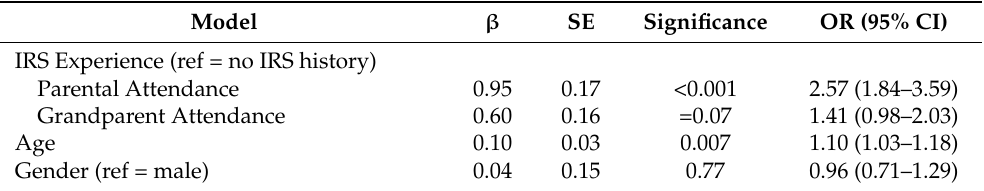
Table 2. Logistic regression analysis predicting not living with either biological parent